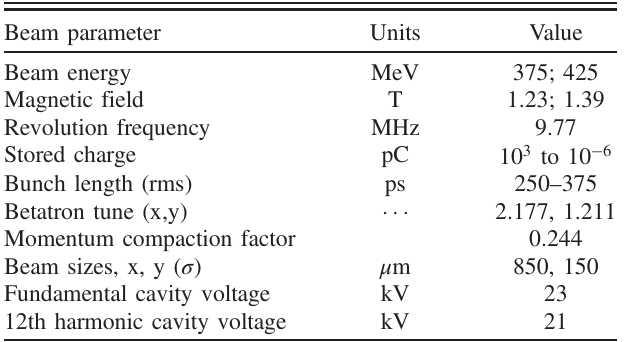
TABLE I. Summary of the PAR and electron beam parameters used in the studies.